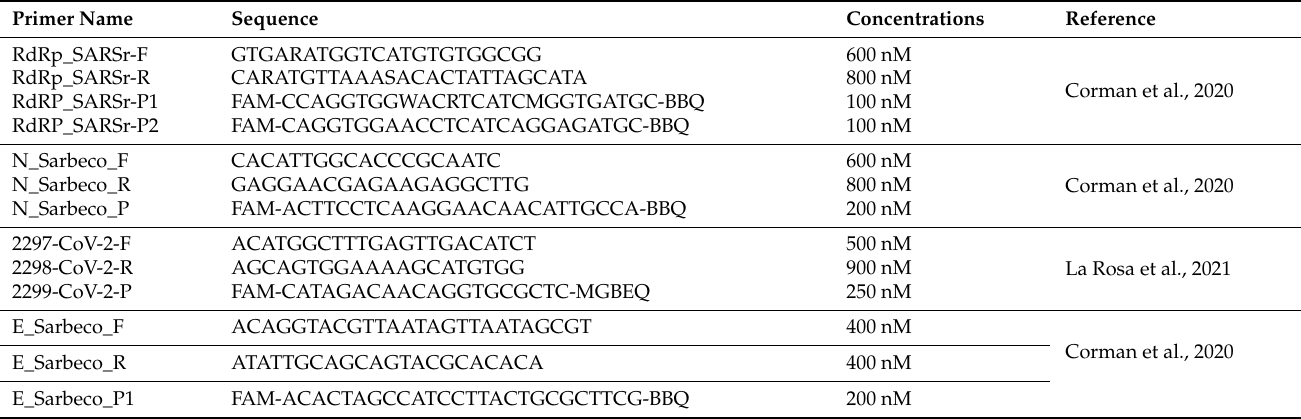
Table 1. Sequence, concentrations, and reference of primers and probe used in this